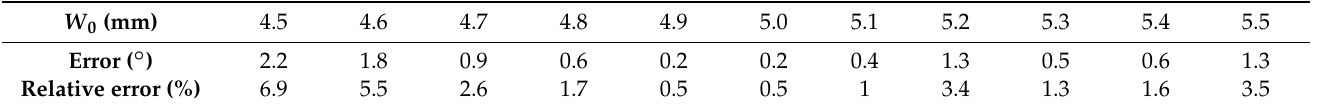
Table 9. Comparison between model calculation and HFSS simulation results when parameters of W 0 change.